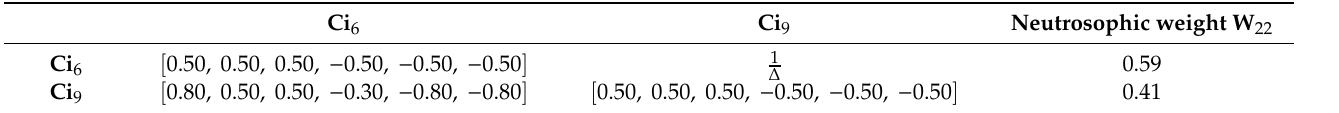
Table 15. Interior interdependencies matrix of factor C 10